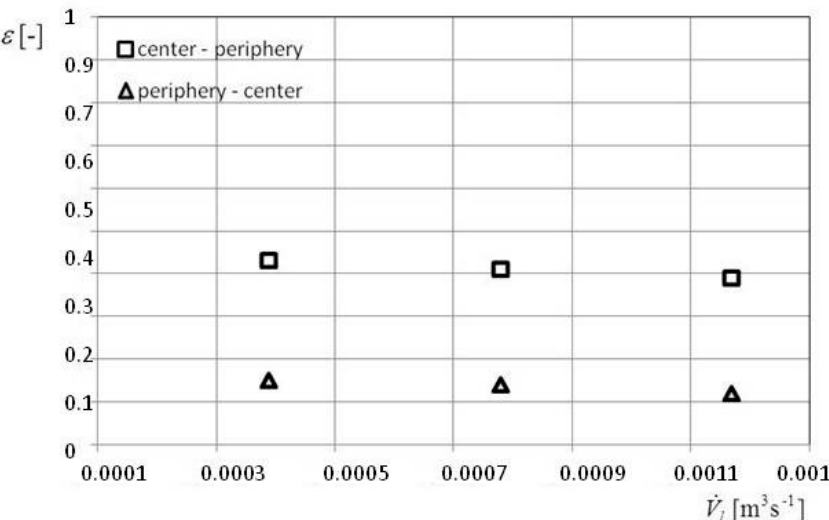
Figure 21. Experimental values of the effectiveness for direct and counter impinging liquid